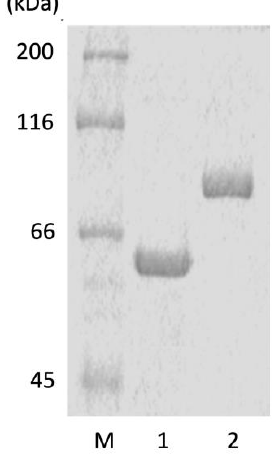
Figure 1. Sodium dodecyl sulfate–polyacrylamide gel electrophoresis (SDS-PAGE) analysis of the purified alginate lyases. SDS-PAGE was performed on 10% polyacrylamide gel. The gel was visualized by Coomassie brilliant blue. The samples were loaded in the following order: M, protein maker (molecular masses shown on the left); 1, rAlyFRA; and 2,